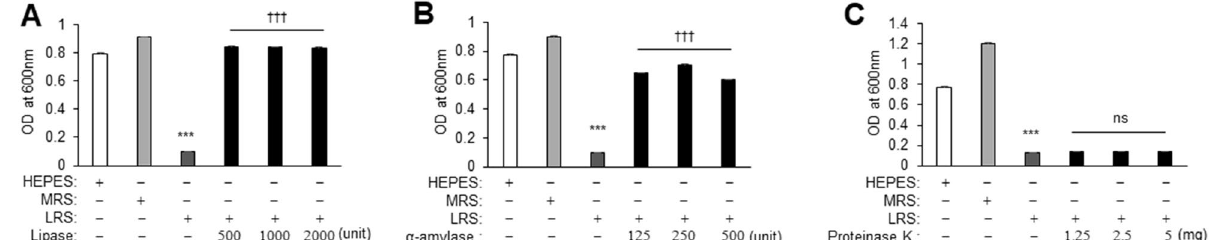
Figure 6. Exploring antibacterial substances in LRS. ( A – C ) Antibacterial effects of LRS and enzyme-treated (α-amylase, lipase, and proteinase) LRS against P. gingivalis after a 24 h incubation. Significant differences from control and LRS treatments ( p < 0.001) are indicated by (***) and ( ††† ),